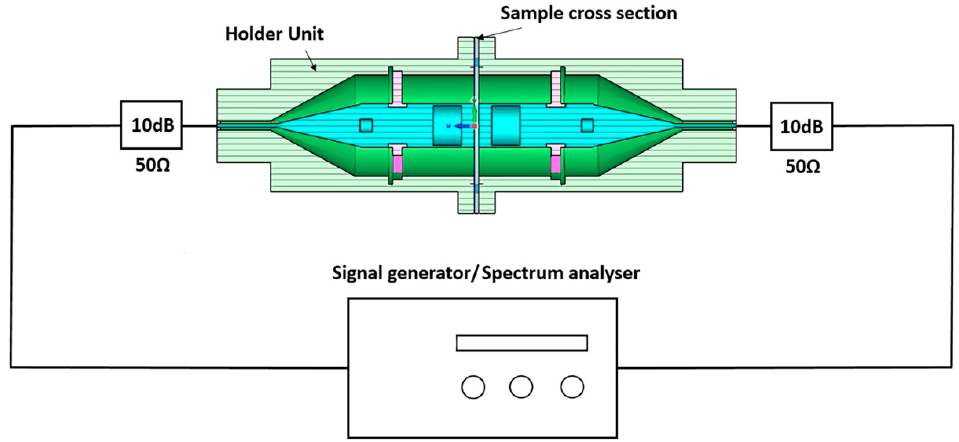
Figure 2. Schematic of the measurement setup for electromagnetic shielding according to ASTM D4935-18. Reprinted from [21], copyright (2019), with permission from Elsevier. Other existing standards are, e.g., related to durable relocatable shielded enclosures (ASTM E1851-15) [24], (IEEE 299-2006) enclosures and boxes [25], or EN 61000-4-21